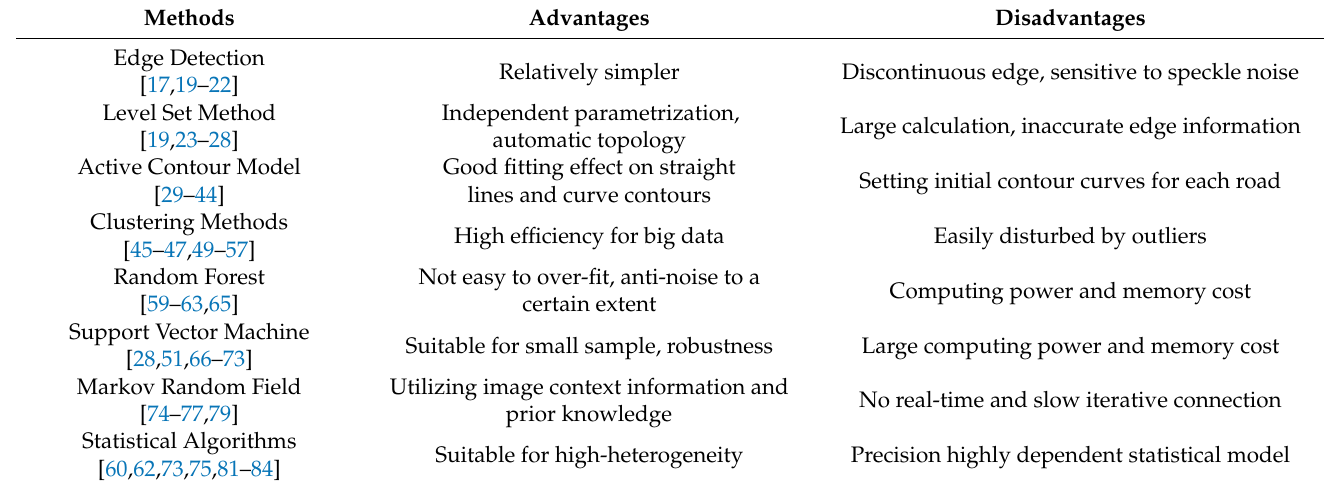
Table 1. Advantages and disadvantages of traditional water body extraction methods.